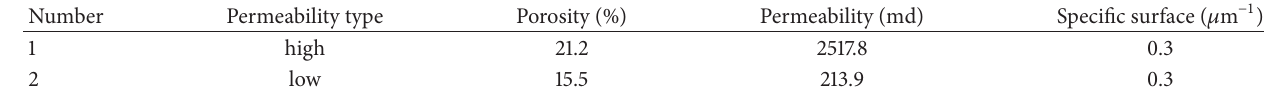
Table 1: Physical properties of the microscopic model.